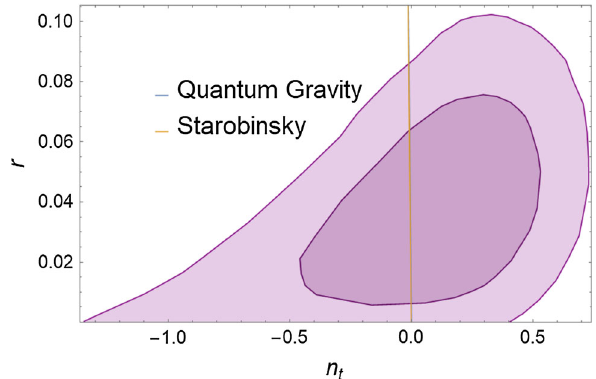
Fig. 1 We plot the tensor-scalar ratio r against the tensor spectral tilt n t for Starobinsky inflation and Effective Quantum Gravity, using (25) and choosing m 2 / H = 0 . 001, against the 2018 Planck results [17]. The line for Starobinsky’s model (orange line) overlaps the blue line corresponding to Quantum Gravity precisely, making it impossible to distinguish between both lines with current